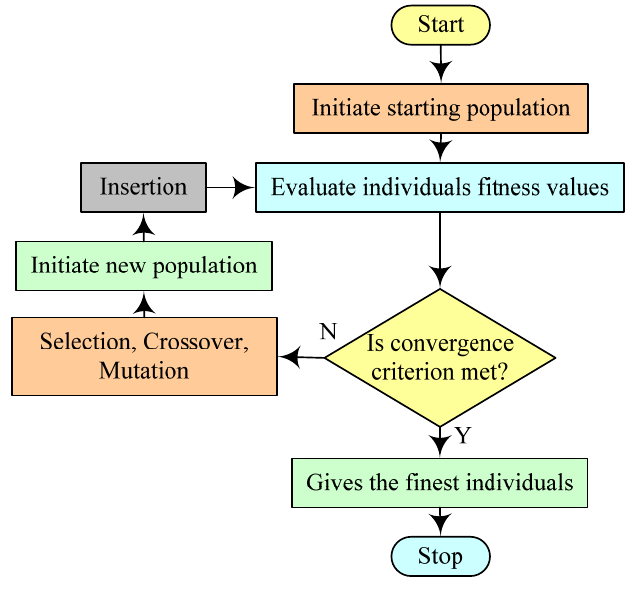
Figure 23. Flowchart of GA